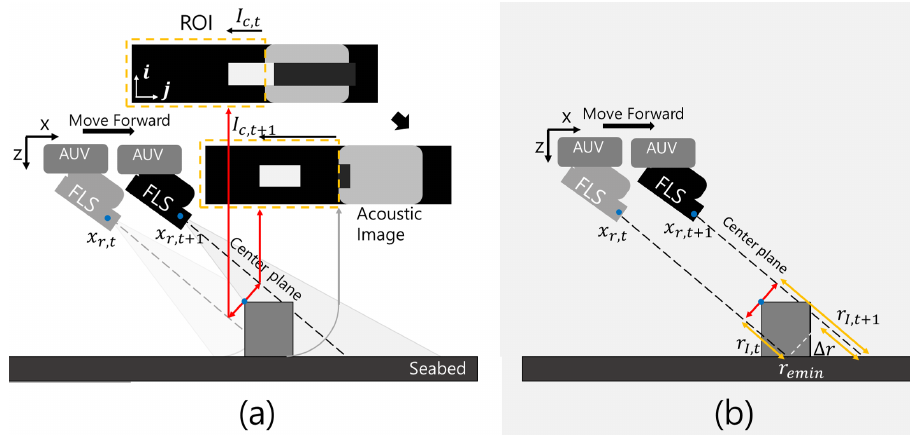
Figure 5. Change in length of the highlight in the front area of the sonar image with the change in sonar position. ( a ) presents highlight changes in sonar images of FLS, and ( b ) shows the corresponding changes in